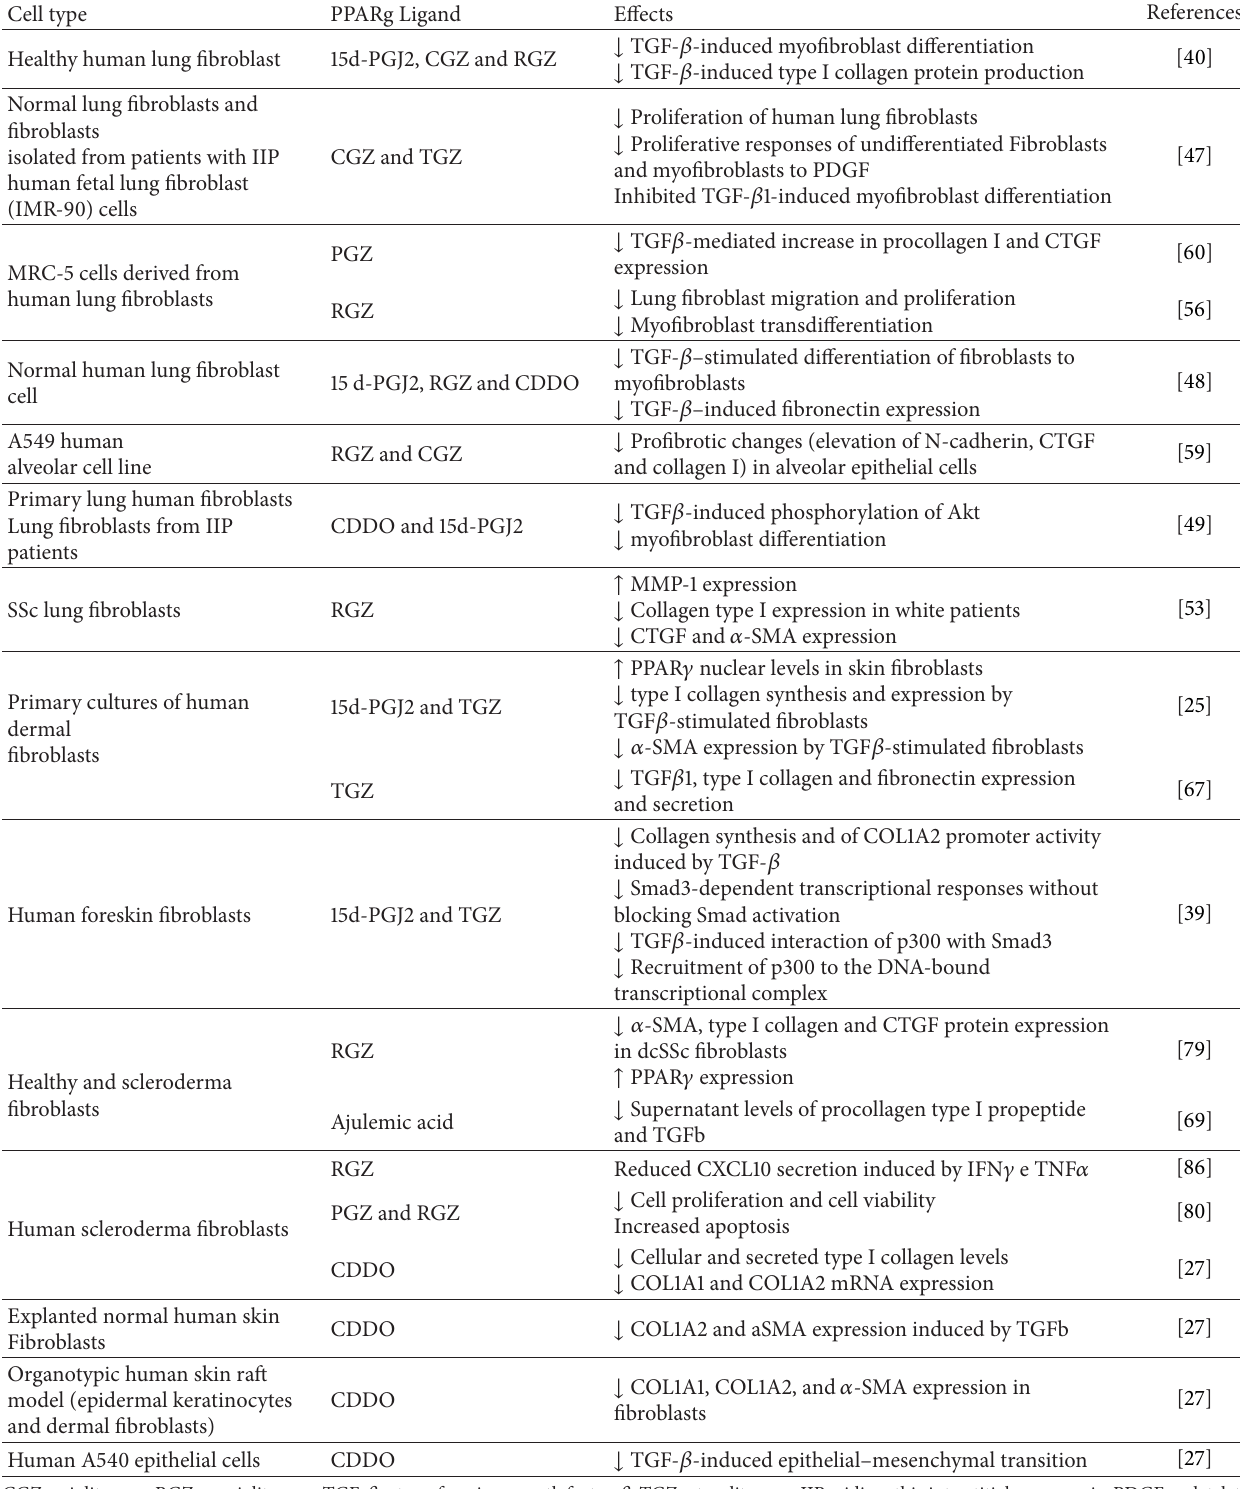
Table 1: In vitro studies of antifibrotic effects of PPAR 𝛾